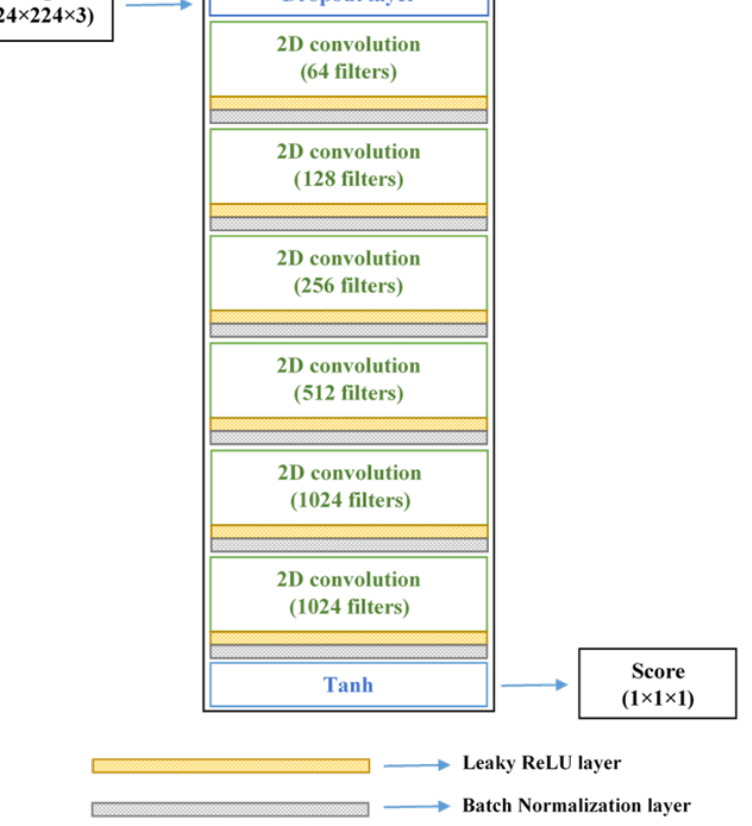
Figure 3. Network architecture of GAN-discriminator model.